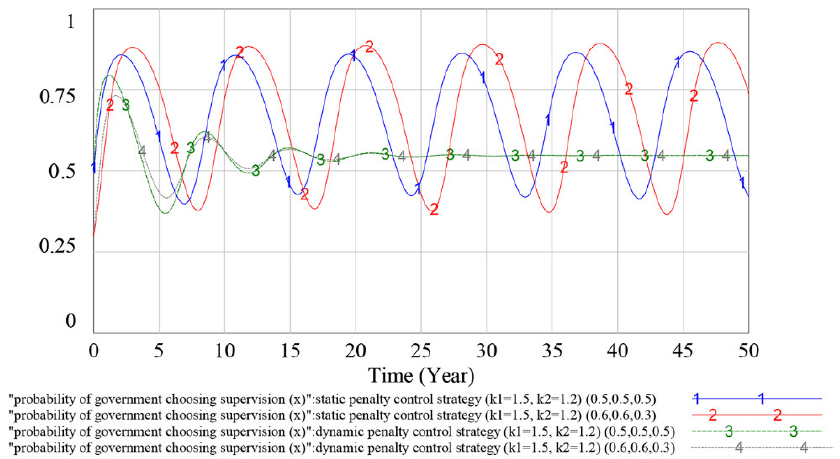
Figure 13. Influence of different initial values on the government’s strategy choices under different penalty control strategies.